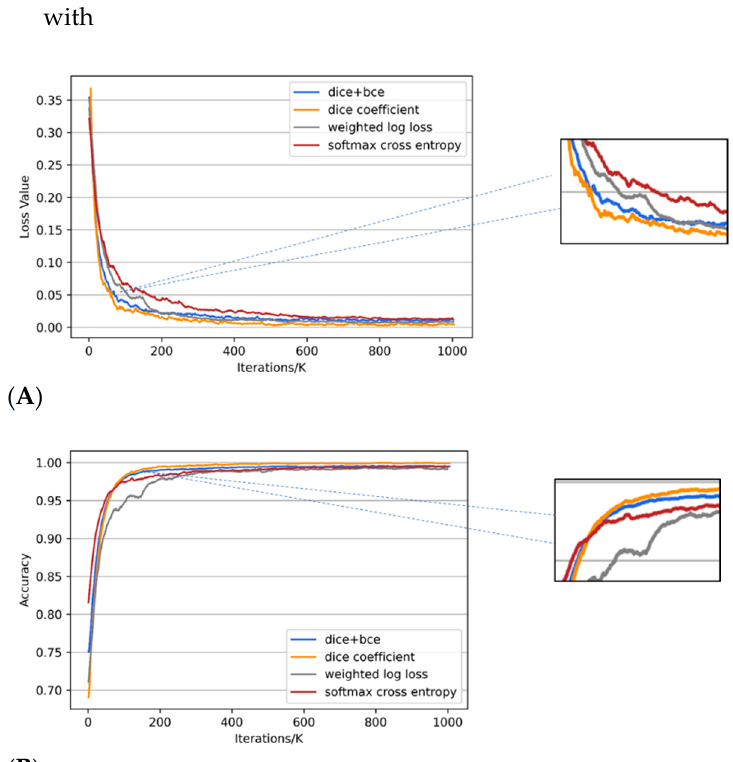
Figure 9. Progression of loss values ( A ) and training accuracy ( B ) for four loss functions used with Nested SE-Deeplab during training. The loss functions are softmax cross entropy (softmax), weighted log loss, dice coefficient (dice), and dice coefficient added with binary cross entropy (bce).